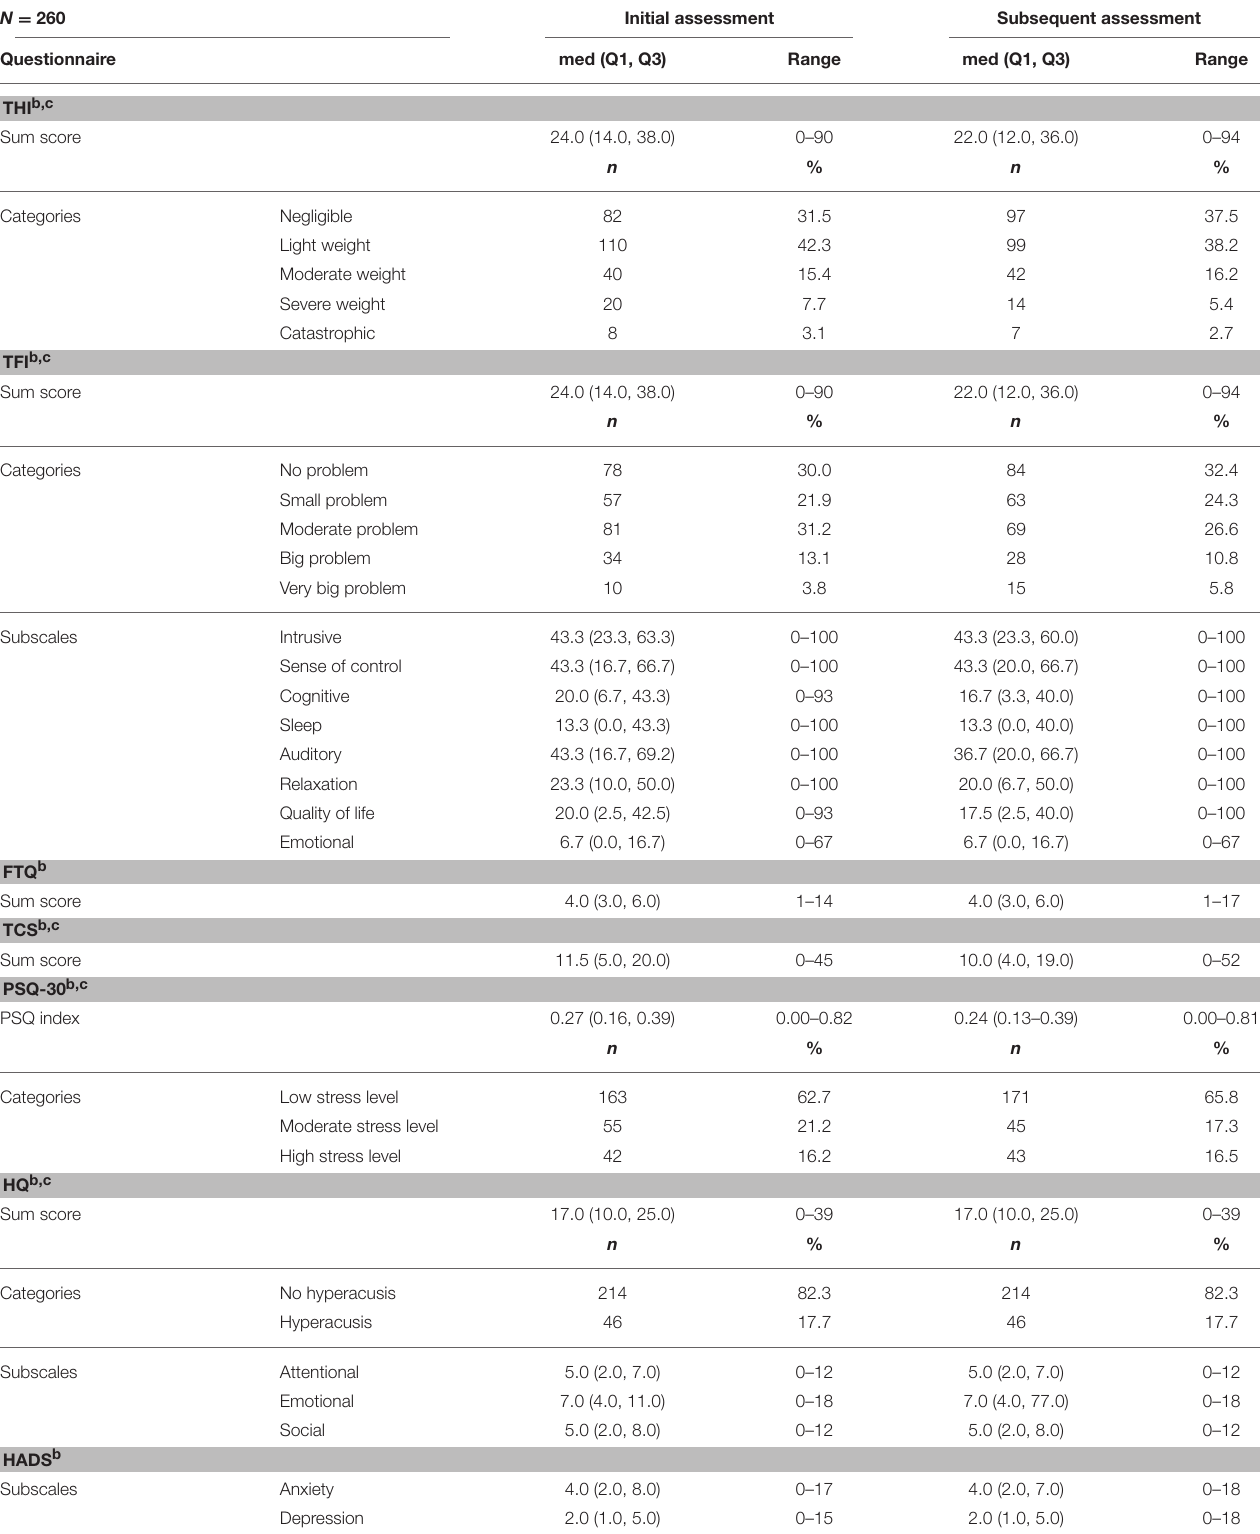
TABLE 3 | Descriptive analyses of tinnitus-related